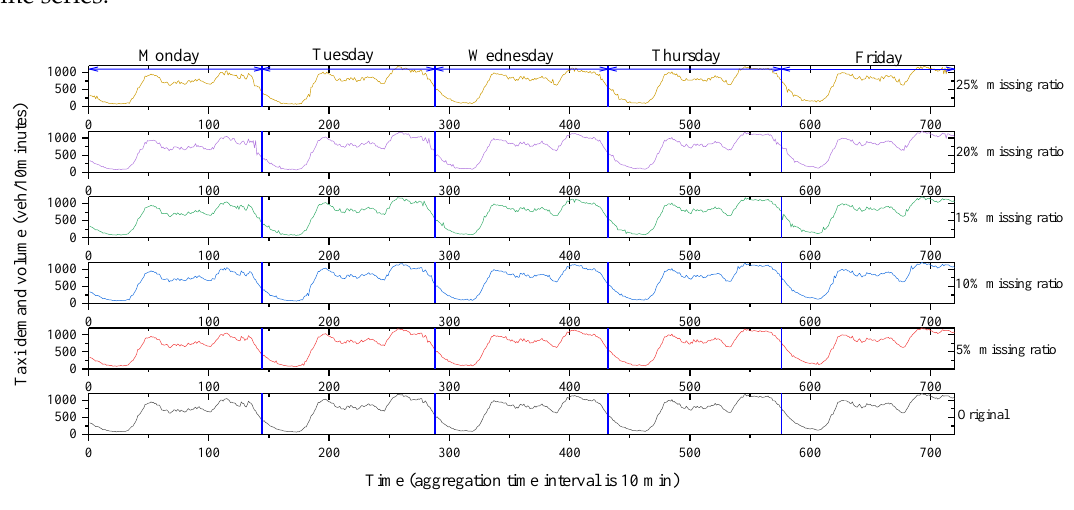
Figure 10. Time series comparisons with different missing ratios.